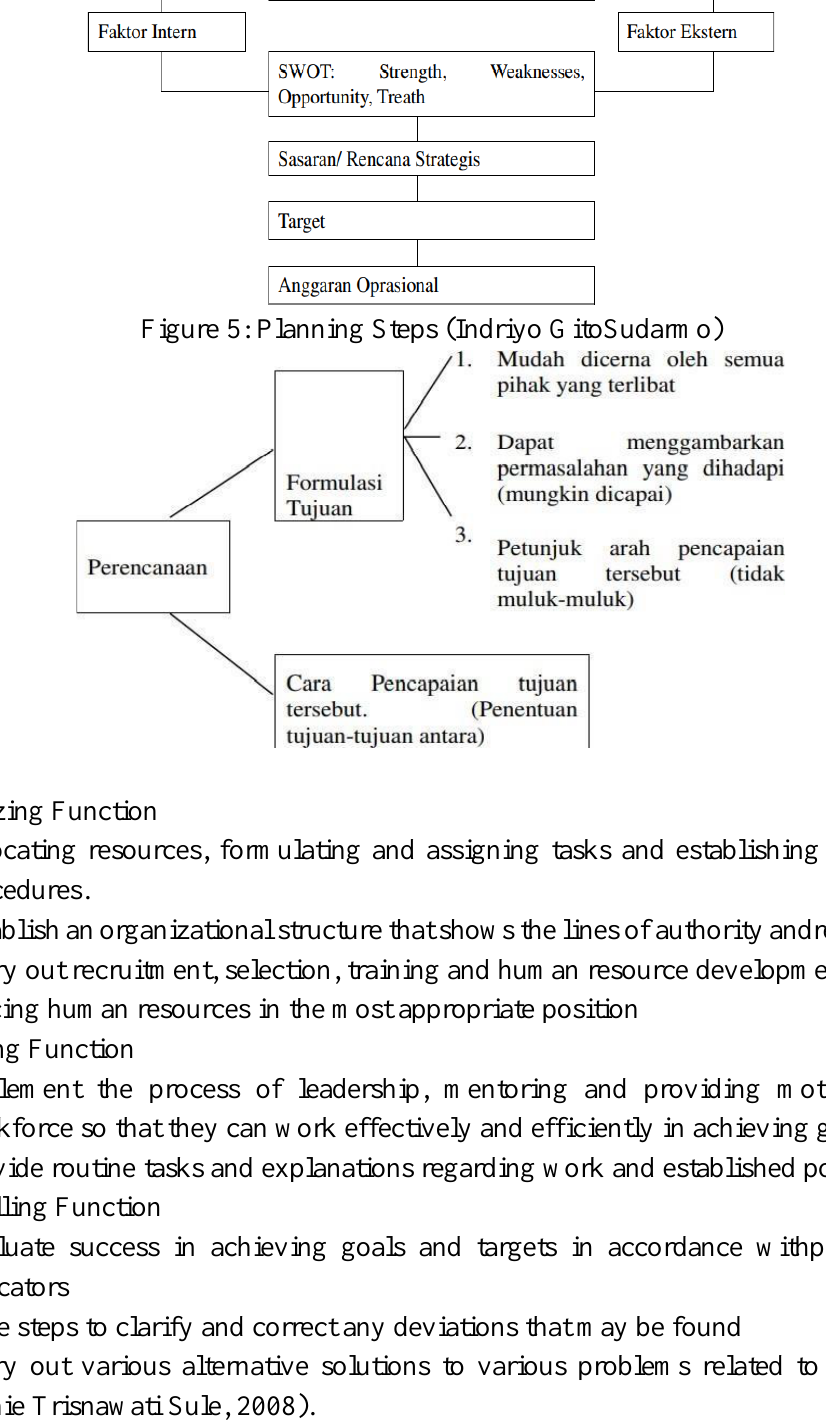
Figure 5: Planning Steps (Indriyo